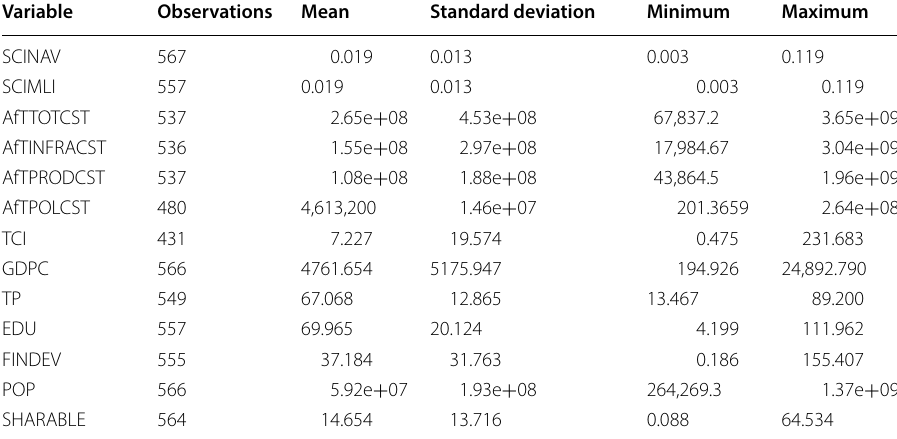
Table 7 Descriptive statistics on variables